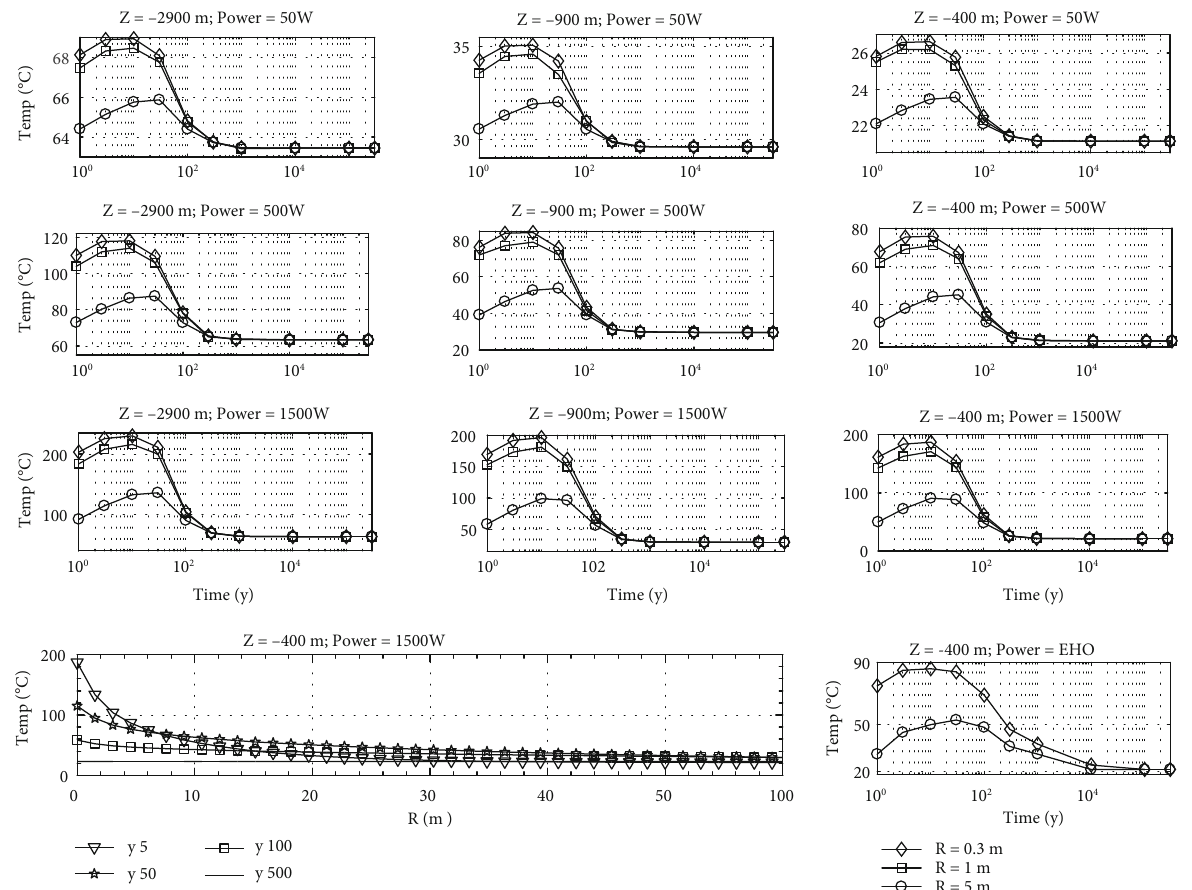
Figure 6: Temperature evolution with time at radial distances (interface waste zone/rock, R = 0 : 3 m ; at R = 1 and 5 m in the host rock) for di ff erent heat outputs (50 W, fi rst row; 500W, second row; 1500W, third row) and di ff erent disposal depths for observation points half-way the 200m deep disposal zone ( Z = − 2900m , fi rst column; Z = − 900m , second column; Z = − 400m , third column). Row 4 shows temperature evolution with (1) radial distance at selected times for 1500W at Z = − 400 m and (2) time for EHO at Z = − 400 m ( R = 0 : 3 and 5